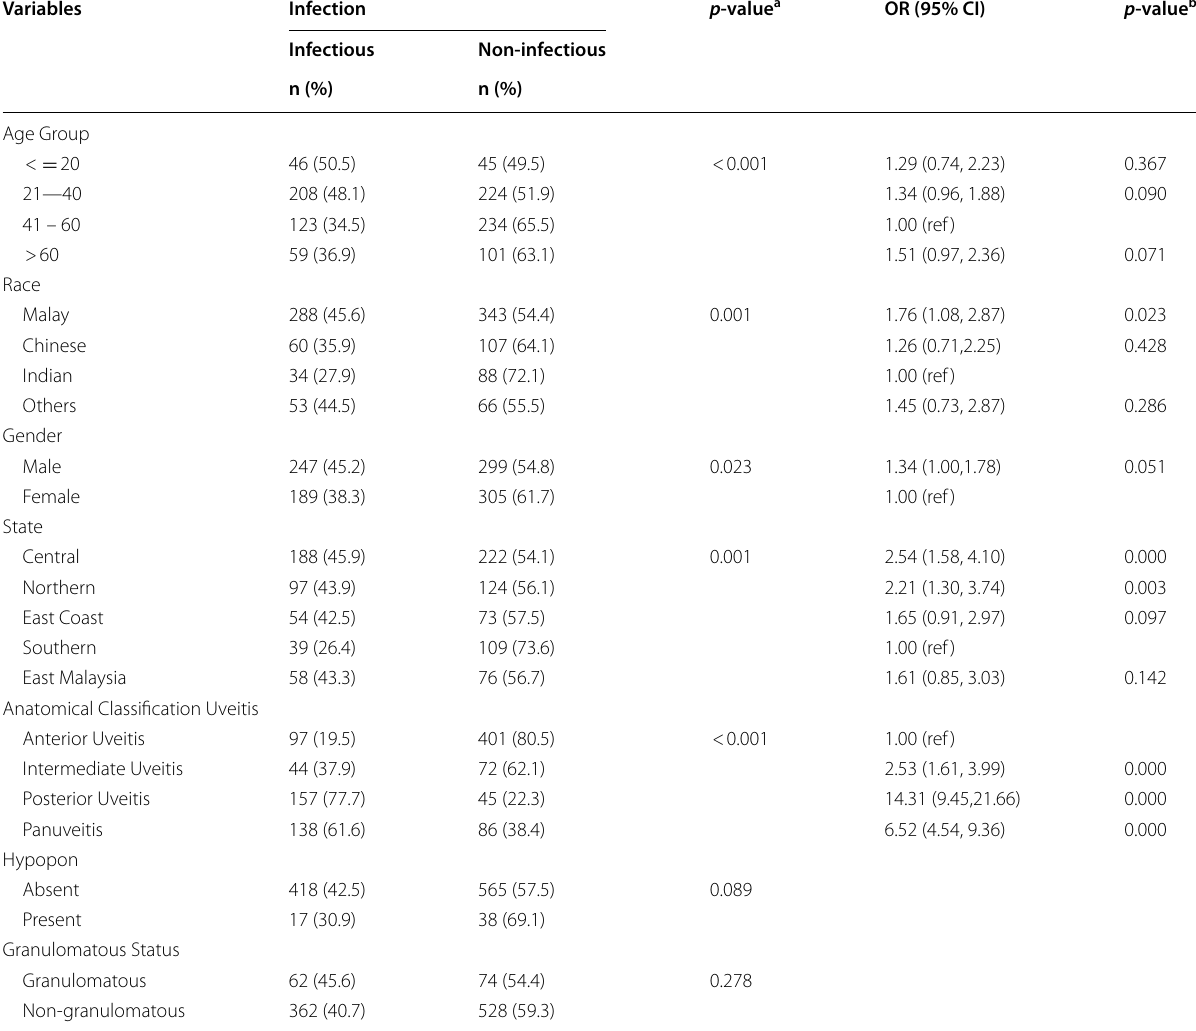
a Chi-square test b Multiple Logistic Regression